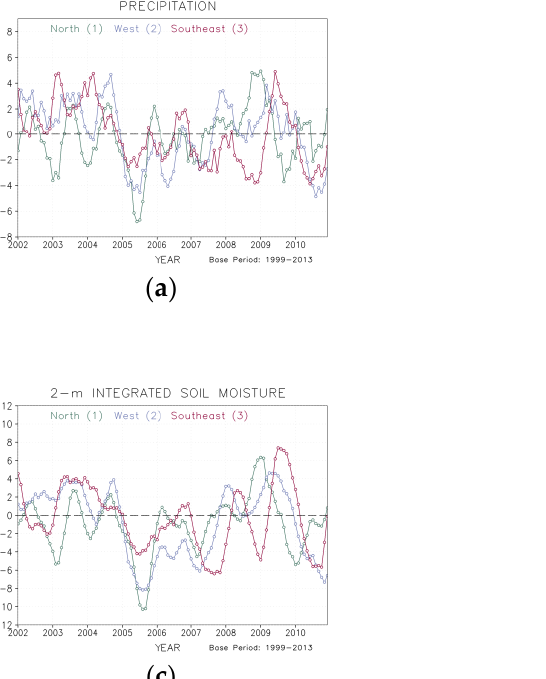
Figure 2. Standardized anomaly of observed: ( a ) precipitation and ( b ) temperature at the following station sites: Coari in Amazonas (AM) (green curve, for 2005), Cruzeiro do Sul in Acre (AC) (blue curve, for 2010) and Vilhena in Rondônia (RO) (red curve, for 2010). Monthly mean and standard deviation calculated over the base period 1981 – 2010.